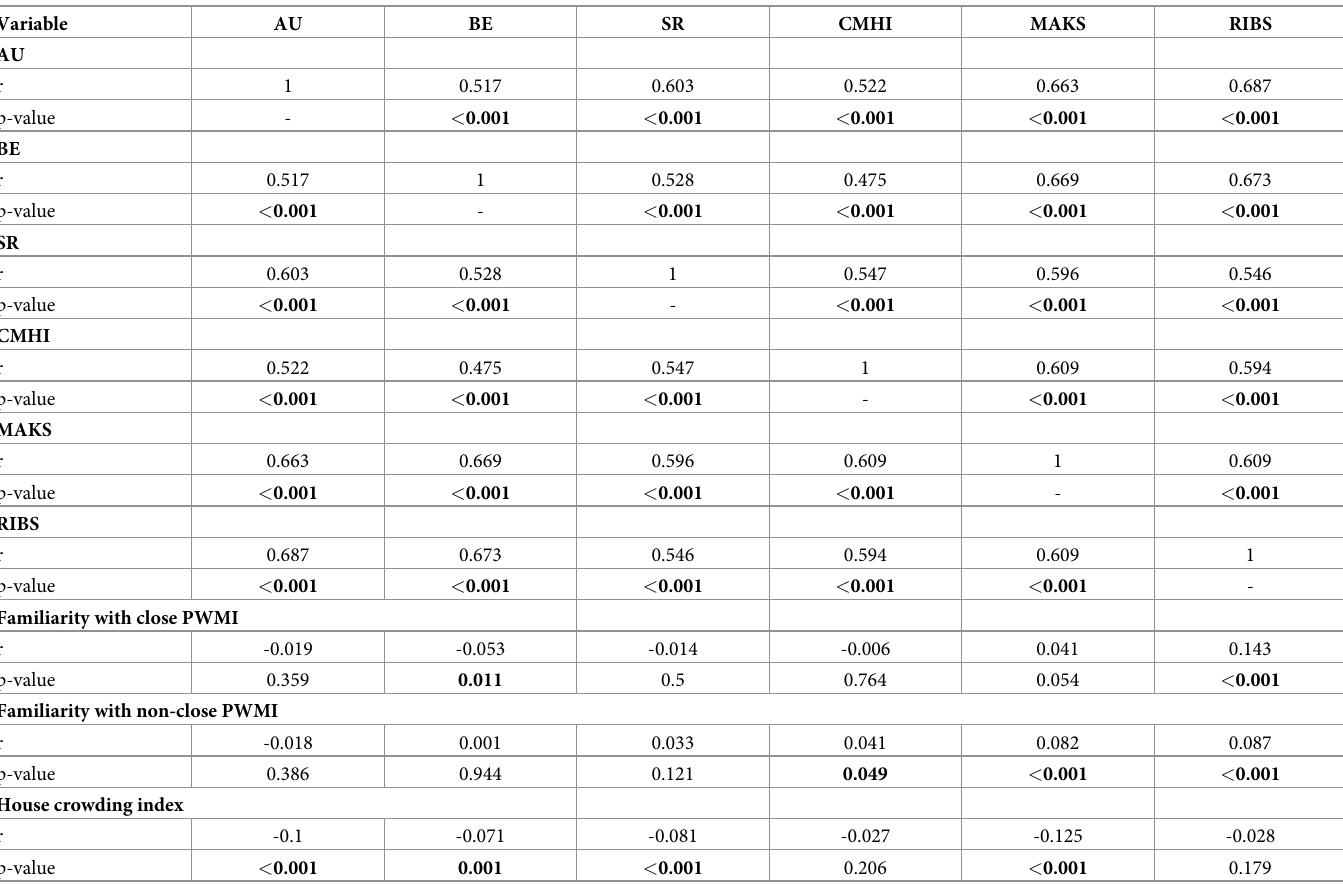
Table 3. Correlation between continuous variables and the CAMI subscales, MAKS and RIBS